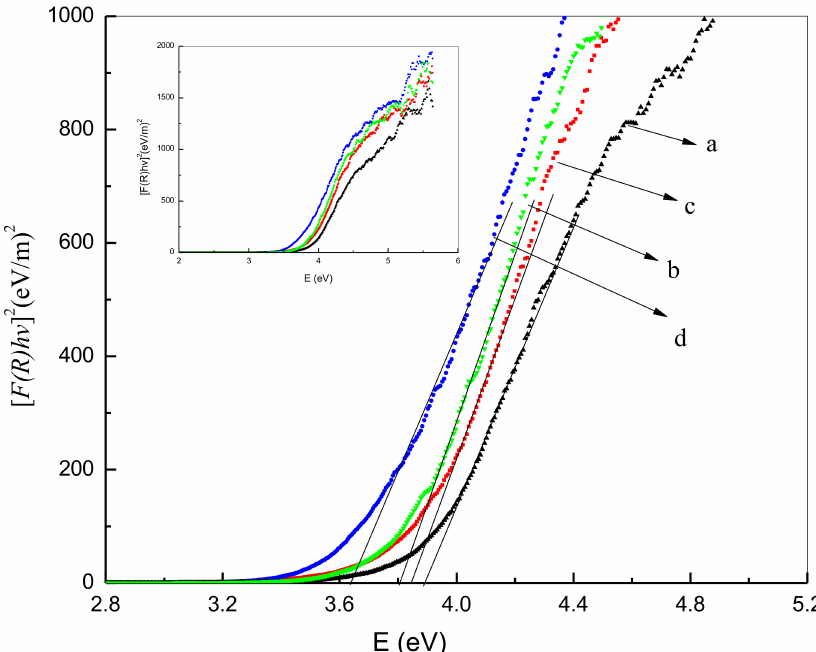
Figure 8. Nanoparticle energy band gap at calcination temperatures of 500 ◦ C ( a ), 600 ◦ C ( b ), 700 ◦ C ( c ), and 800 ◦ C ( d